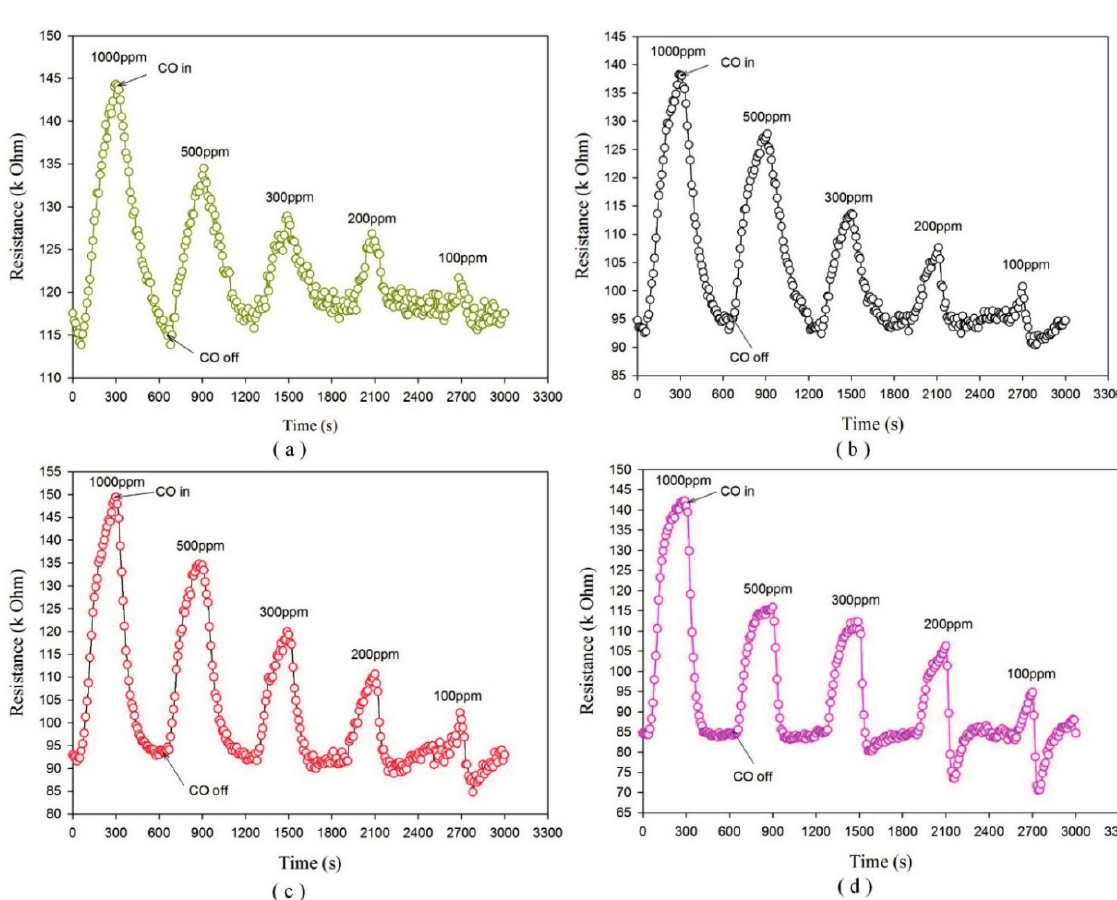
Figure 8. Variation in resistance of ZnO gas sensors during the cycles of CO injection and termination under various operating temperatures, ( a ) 110 °C; ( b ) 140 °C; ( c ) 160 °C; ( d ) 180